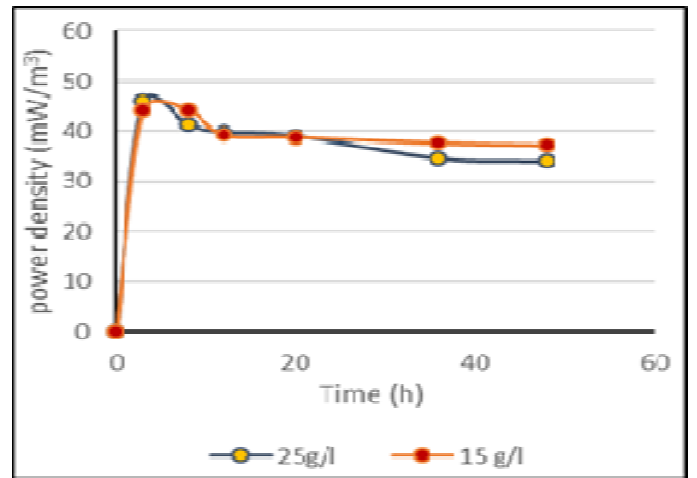
Fig. 1 show the performance of the MDC with 150 K Ω of the external resistance and with 25-15 g/L of NaCl in desalination chamber with continuous pure